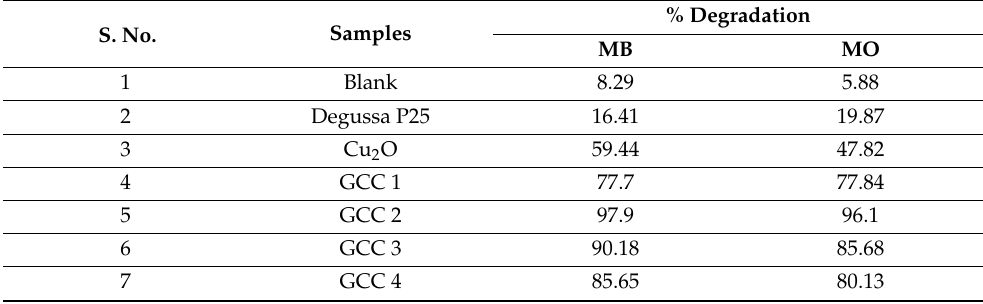
Table 1. MB and MO degradation percentage.